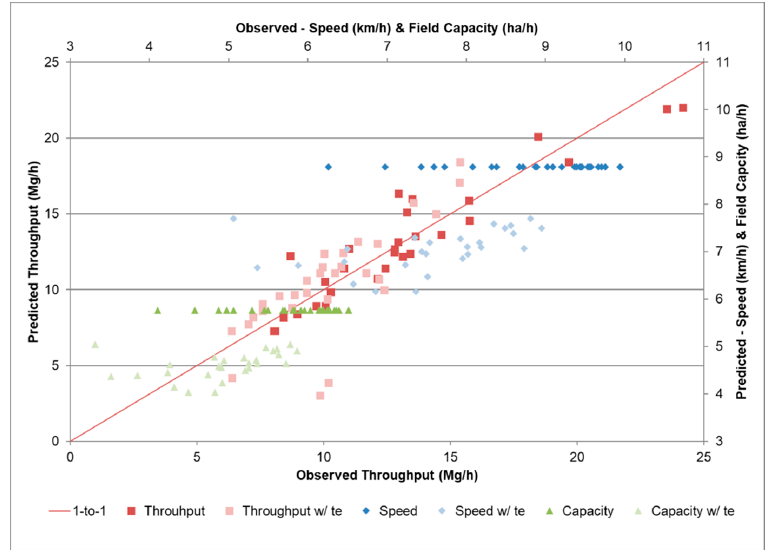
Figure 8. Comparison of the observed and calculated productivity factors for Field 1. The observed from the field data and calculated [4] (v e = 12.0 km/h, E f = 0.74, and W s = 6.55 m, t e = 39 s, and M b = 0.56 Mg). The red line indicates a perfect correlation between calculated and observed values (1:1 line).